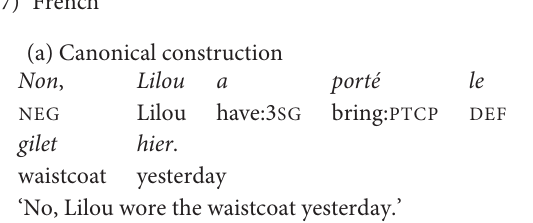
‘No, Lilou wore the waistcoat yesterday.’ 5 Abbreviations for glosses: 3, 3rd person; ACC , accusative; COP , copula; DEF , definite; EXPL , expletive pronoun; NEG , negation; NOM , nominative; OBJ , object; PFV , perfective; PST , past; PTCP , participle; REL , relative pronoun; SG ,